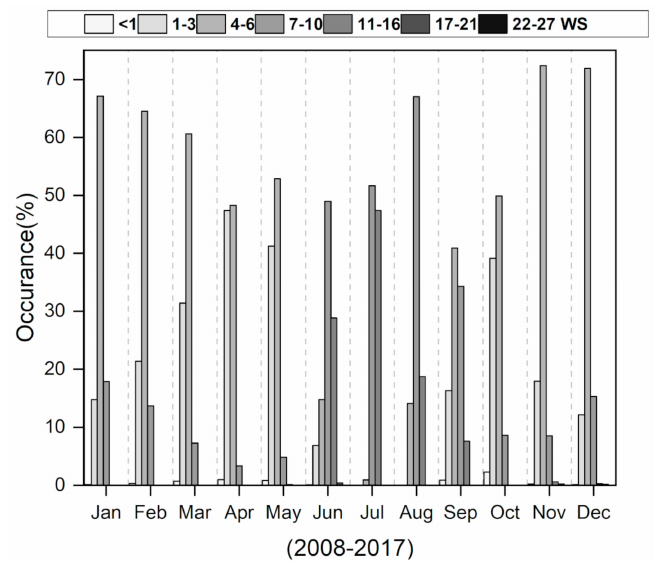
Figure 12. Wind (knots) climatology of the Sindh Coastal zone with respect to the modern Beaufort scale.